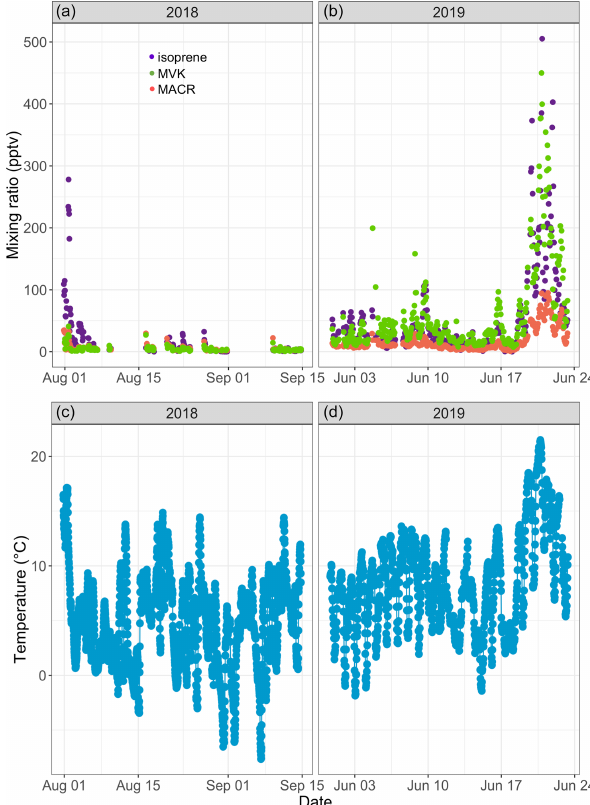
Figure 3. Time series of isoprene (purple), methyl vinyl ketone (MVK; green), and methacrolein (MACR; salmon) mixing ratios (in parts per trillion by volume – pptv) in ambient air at Toolik Field station (a, b) and of 30min averaged ambient temperature (in degrees Celsius) at 4m above ground level (c, d)